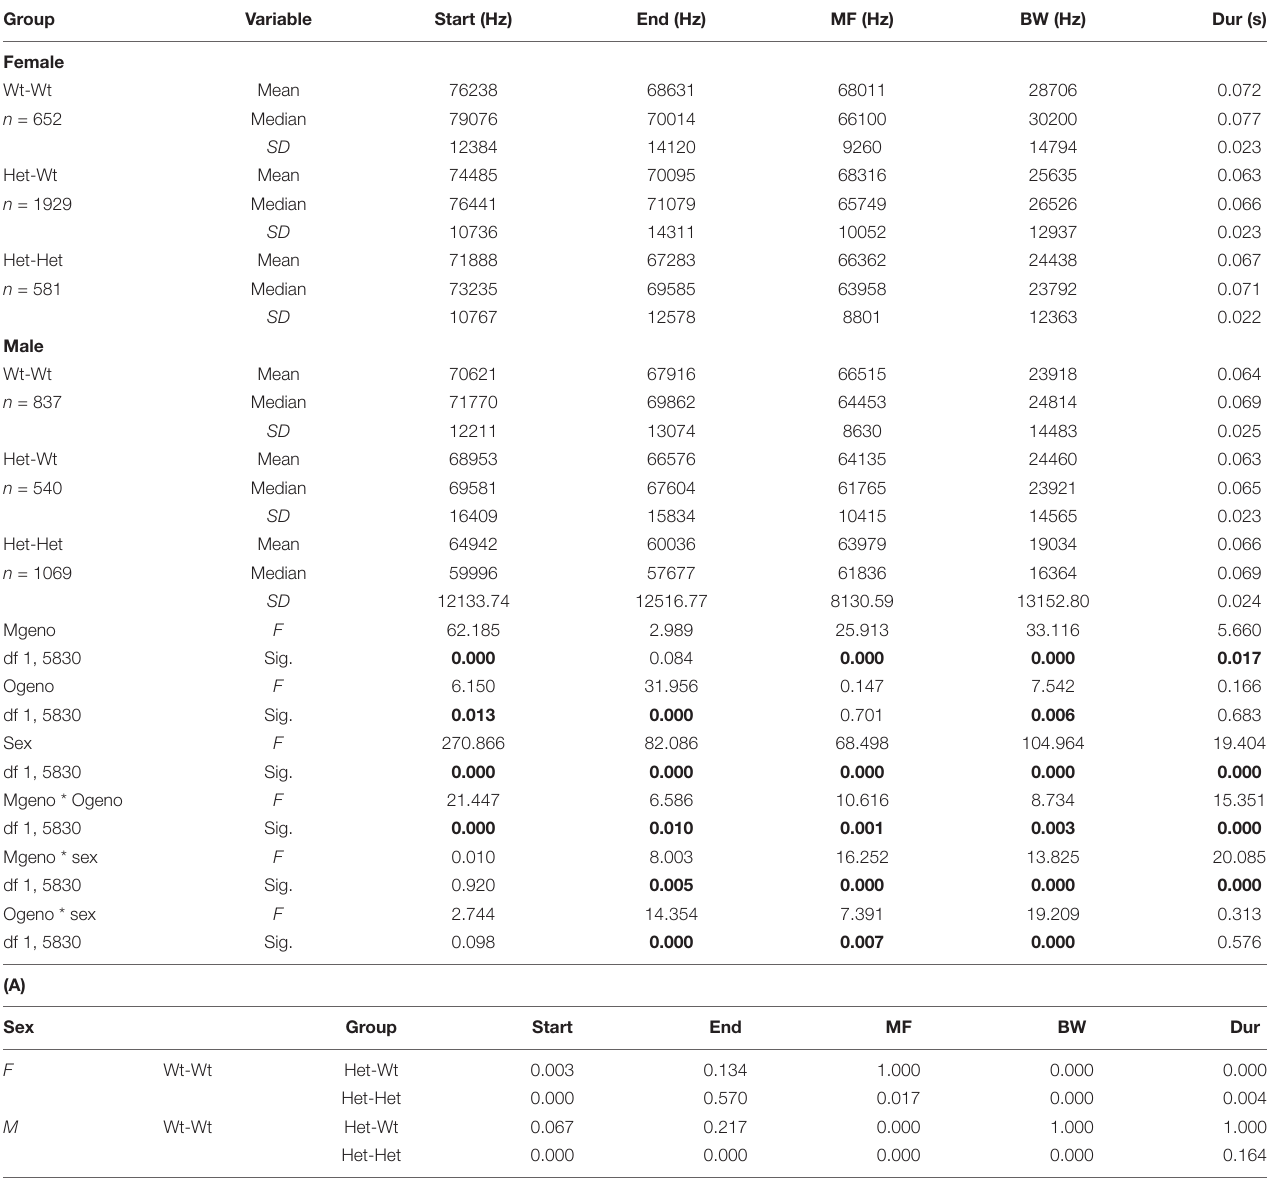
TABLE 2 | The effect of Mthfr genotype and sex on isolation induced syllables.